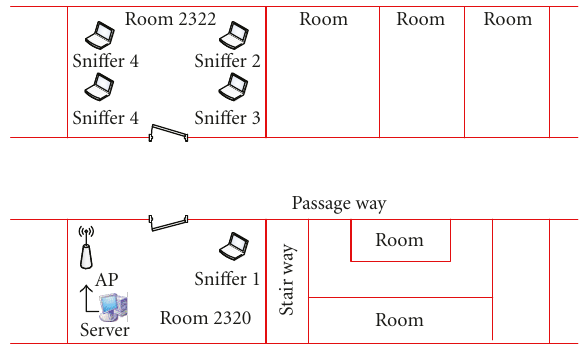
Figure 8: Experimental setups for 802.11 trace